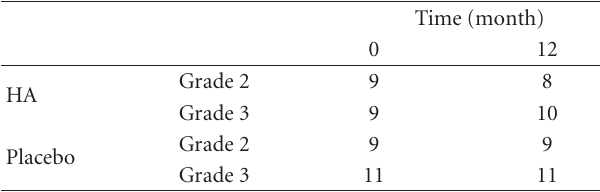
Table 3: Kellgren and Lawrence grade before and 12 months after administration.